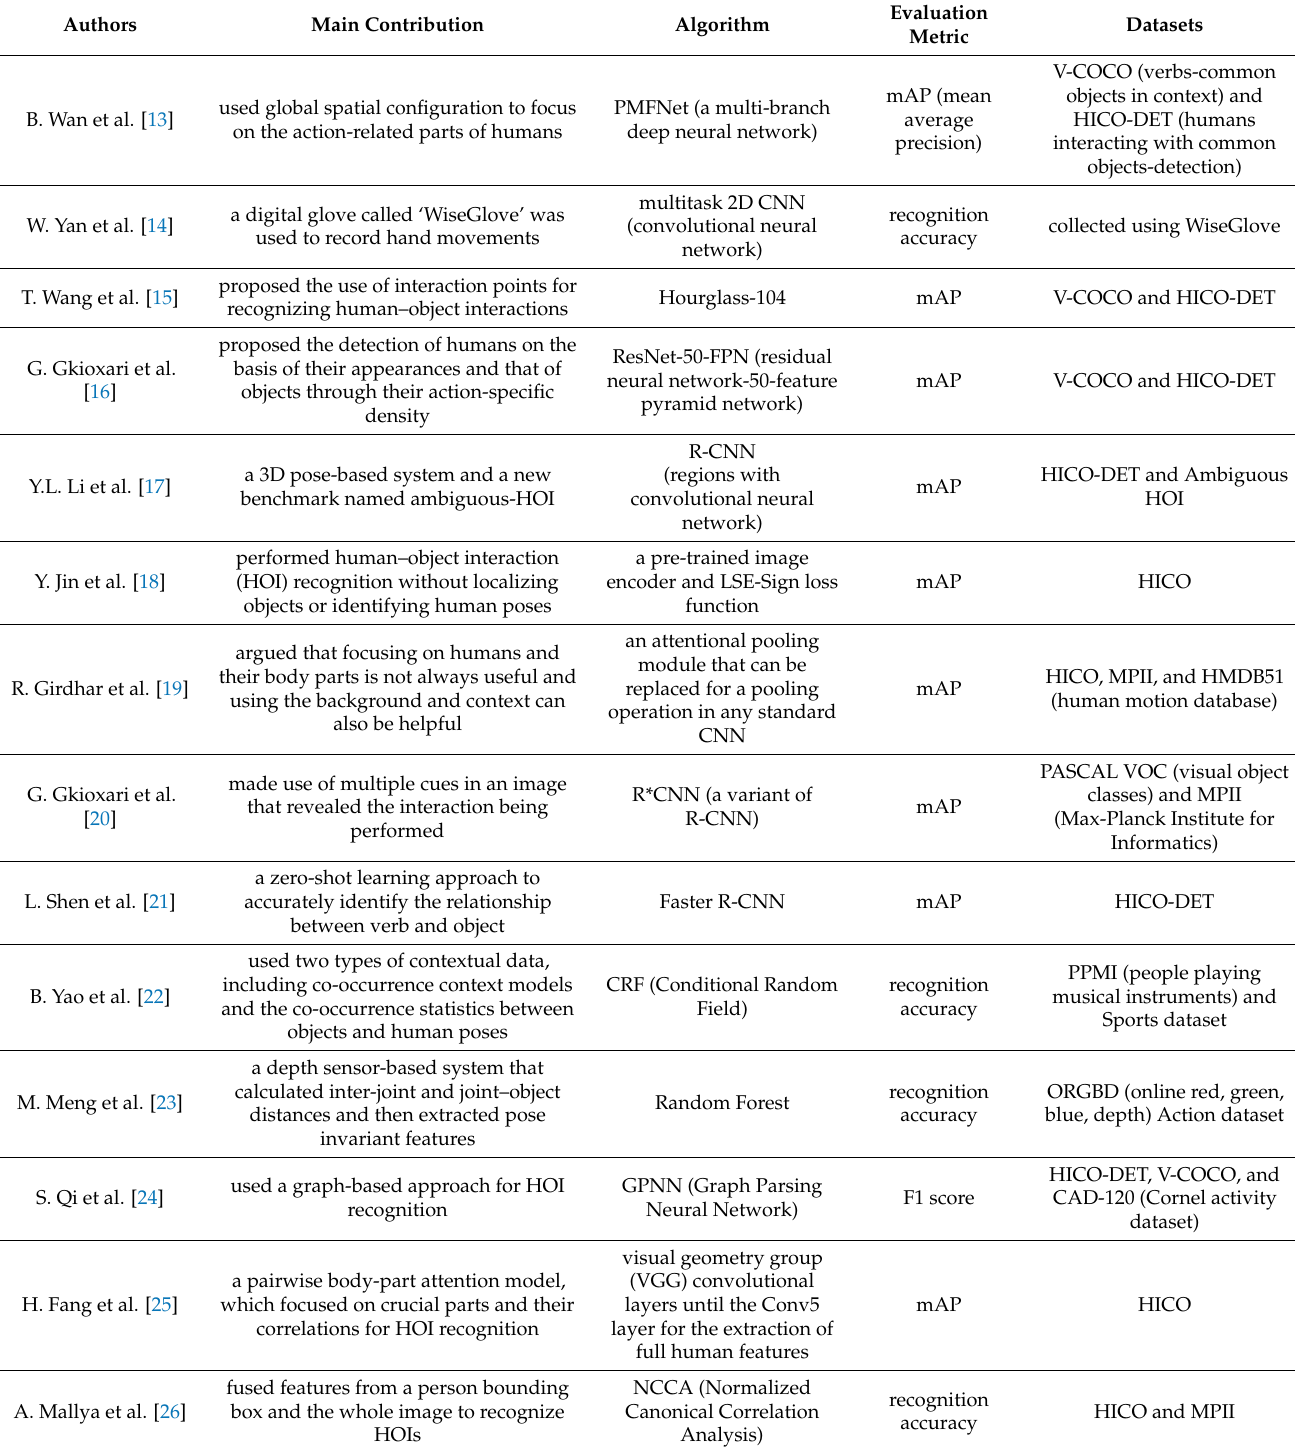
Table 1. Related